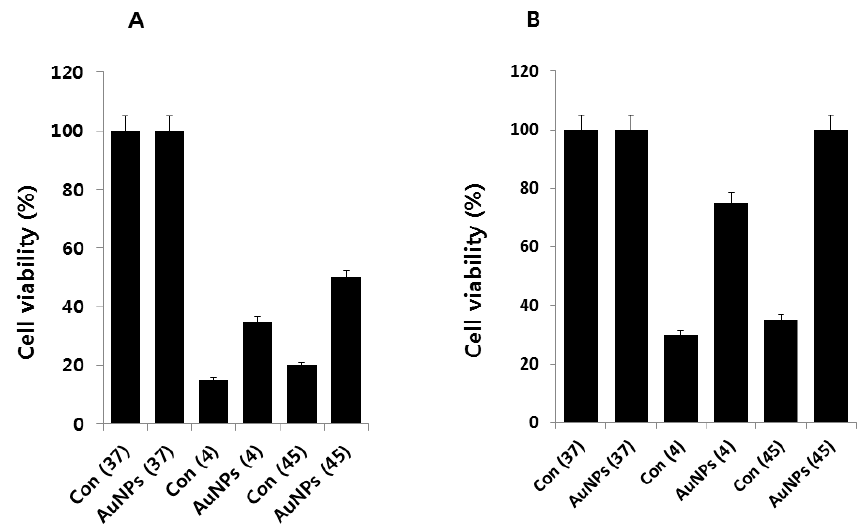
Figure 3. Effect of AuNPs on cold and heat stress-induced loss of viability. ( A ) E. coli cells were pre-incubated with AuNPs (1 μ g/mL) for 1 h, stressed at 4 °C or 45 °C, and subsequently recovered for 6 h at 37 °C. Cell viability rates were determined by the colony-counting method and expressed as a percentage of the control; ( B ) E. coli cells were pre-incubated with AuNPs (1 μ g/mL) for 1 h, stressed at 4 °C or 45 °C, and subsequently recovered for 12 h at 37 °C. Cell viability rates were determined by the colony-counting method and expressed as a percentage of the control. Data are shown as means and standard deviations calculated from three independent experiments. AuNP-treated groups showed statistically significant differences from the control group by Student’s t -test ( p < 0.05).